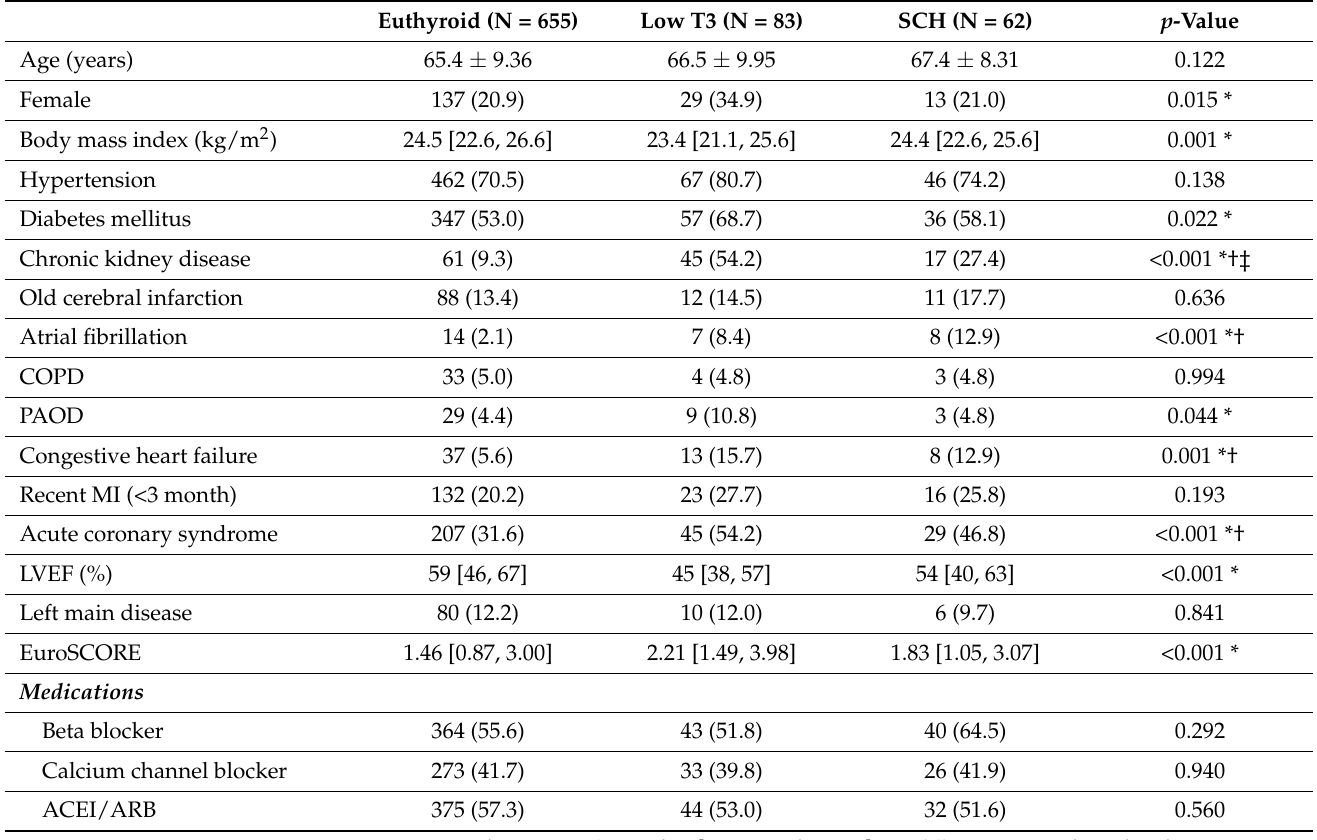
Table 1. Baseline characteristics of the patients among the three groups designated by thyroid function